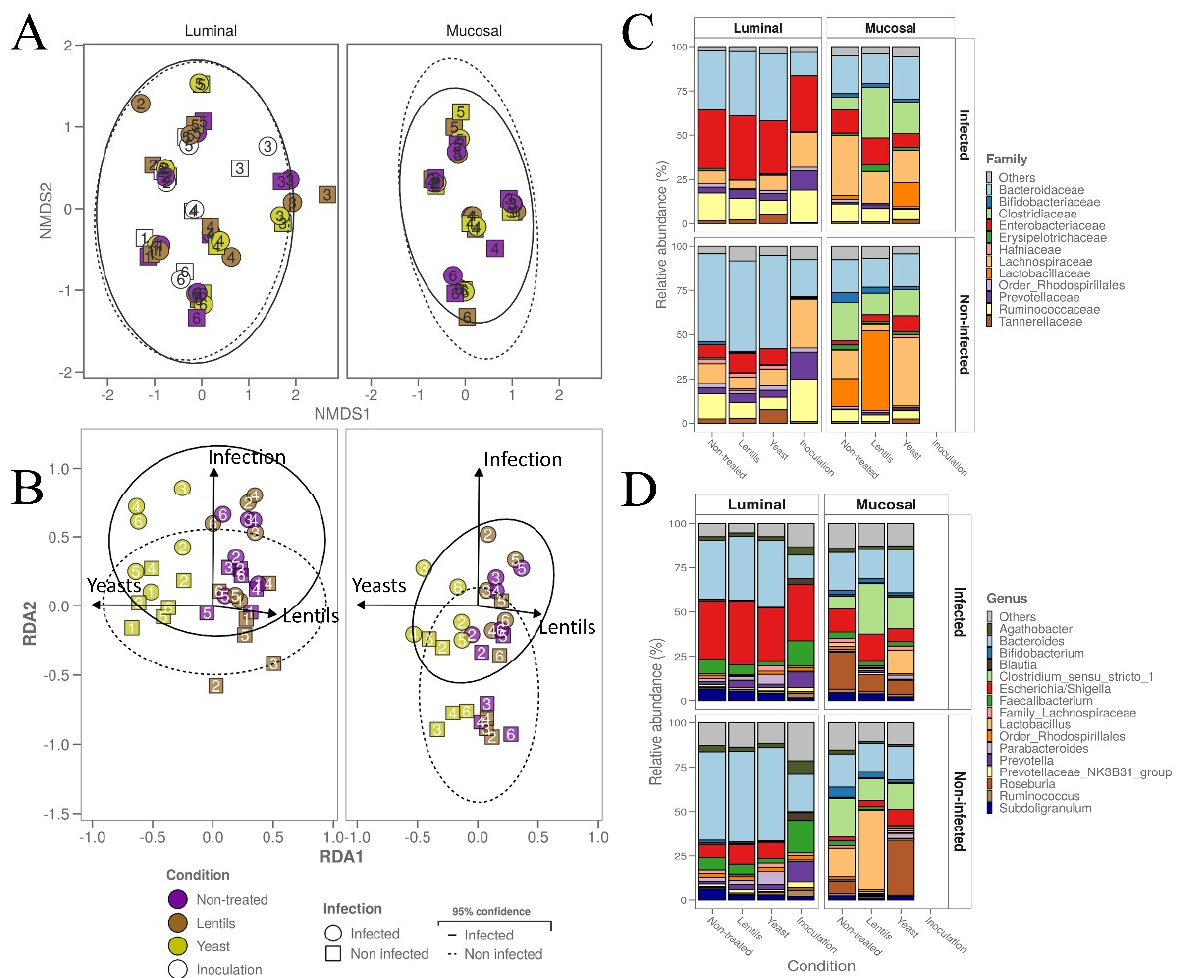
Figure 10. Impact of dietary-fiber-containing products on ETEC modulation of microbial community β -diversity. Batch experiments were performed using feces from six healthy donors, challenged or not with ETEC strain H10407, and treated or not with fiber-containing products. ( A , B ) Non-parametric multidimensional scaling (NMDS) ( A ) and distance-based redundancy analysis (db-RDA) ( B ). Two-dimensional plot visualizations report the microbial community β -diversity at the ASV level, as determined by 16S rRNA gene amplicon sequencing. The db-RDA was performed on the ASV table, excluding the inoculation samples (T 0 ) and ASV1 (attributed to the Escherichia / Shigella genus). Infection and fiber products were provided as the sole environmental variables (binary) and are plotted as vectors (arrows). White, purple, brown, and yellow dots represent individual biological replicates at the beginning of the experiment after ETEC inoculation (Inoculation, T 0 ) or after 24 h of fermentation in the non-treated (Non-treated, T 24 ), lentil extract (Lentils, T 24 ), or specific yeast cell walls (Yeast, T 24 ) conditions, respectively. The samples are represented by dot shapes and square shapes for the infected and non-infected conditions, respectively. The 95% confidence ellipse area is also indicated in a continuous line for the infected condition and in a dotted line for the non-infected conditions. The donor number is indicated for each sample. ( C , D ) Cumulative bar plots of the relative microbial community composition at the family ( C ) and genus ( D ) levels. The area graphs show the relative abundance of the 12 most abundant families and 16 most abundant genera in all six different donors confounded.